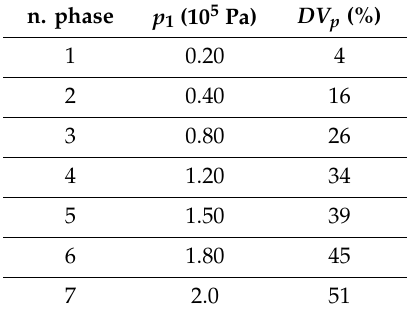
Table 2. Optimized pressure distribution p 1 and consequent volume reduction DV p detected, % respect to the initial value V 0 , during pressing process performed with membrane